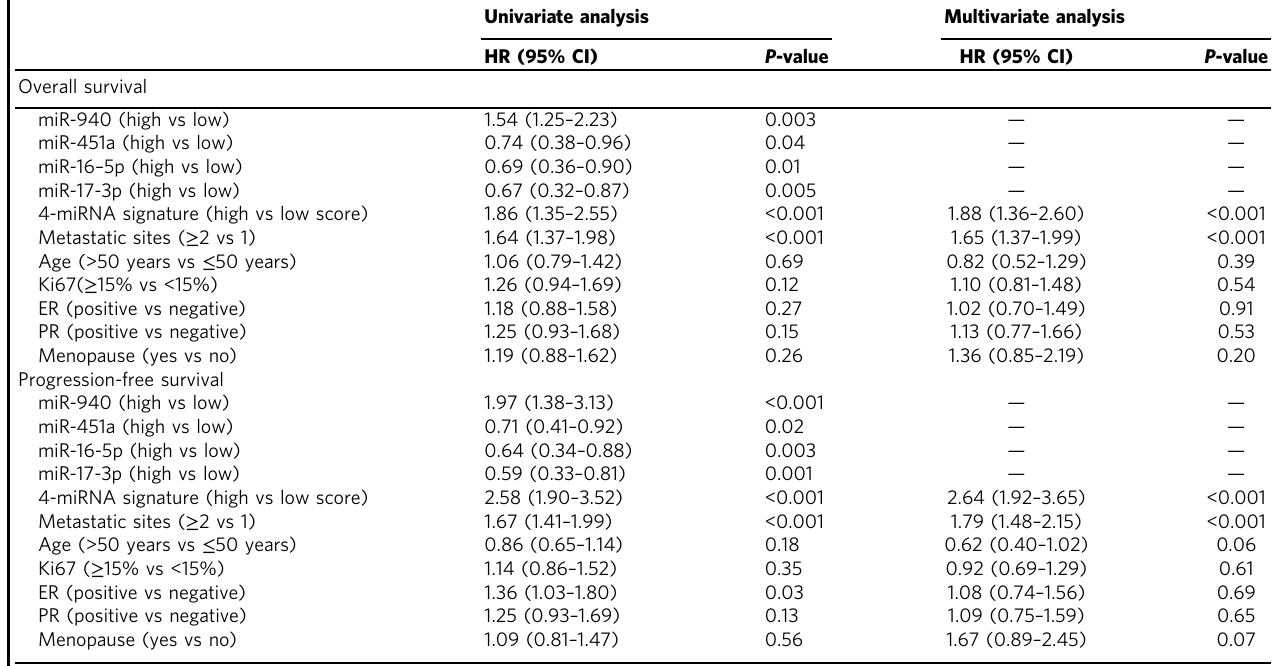
Table 2 Univariate and multivariate Cox regression analysis of 4-miRNA signature and clinicopathological characteristics with overall survival and progression-free survival in the combined two validation